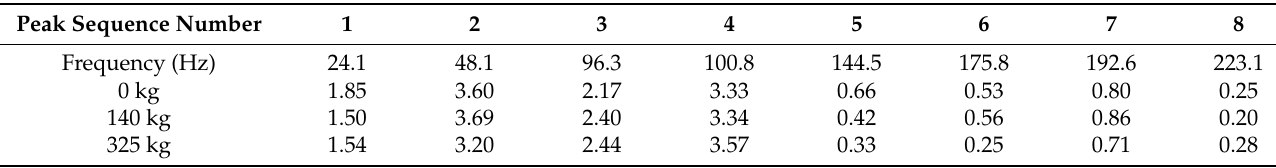
Table 5. Frequency domain peak value of vibration response of elevator with different loads.